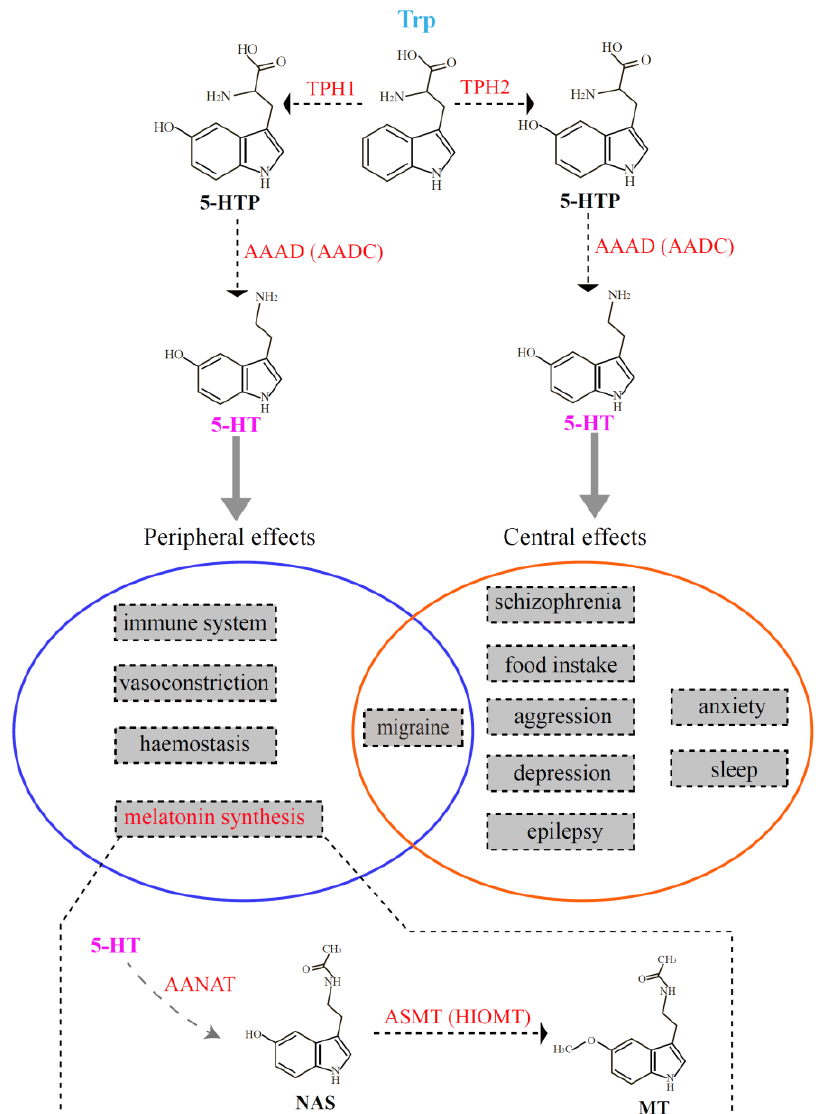
Figure 1. Schematic representation of the two serotonin systems in vertebrates. The top part denotes the process of serotonin biosynthesis, which is also the first two steps in melatonin synthesis. The middle part (in the circles) summarizes the functions regulated by the two serotonin systems. The bottom part interprets the last two steps for melatonin synthesis. 5-HT, 5-hydroxytryptamine; AAAD (AADC), L -aromatic amino acid decarboxylase; AANAT, aralkylamine N -acetyltransferase; ASMT, acetylserotonin- O -methyltransferase; HIOMT, hydroxyindole- O -mehyltransferase; MT, melatonin; NAS, N -acetylserotonin; TPH, tryptophan hydroxylase.